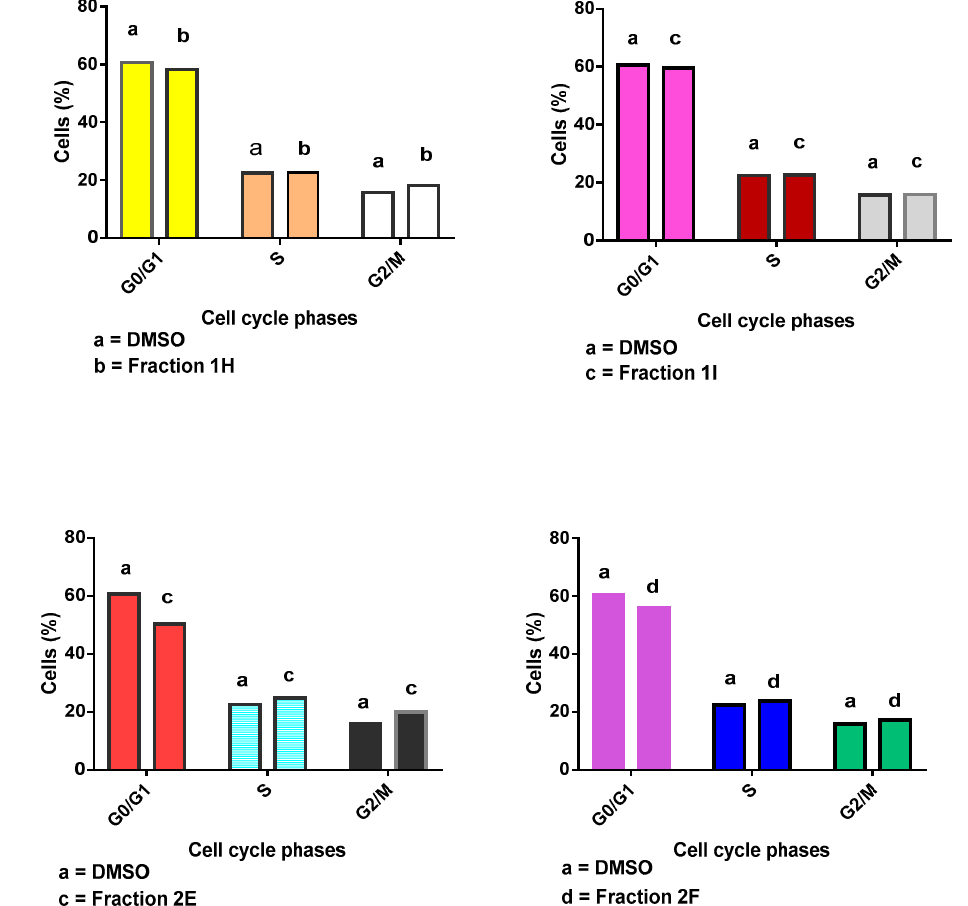
Figure 6. E ff ect of fractions column chromatography 1H, 1I, 2E, and 2F at doubled the IC 50 concentration Figure 6. Effect of fractions column chromatography 1H, 1I, 2E, and 2F at doubled the IC 50 on cell cycle progression in SiSo cancer cell line after 48 h concentration on cell cycle progression in SiSo cancer cell line after 48 h incubation.